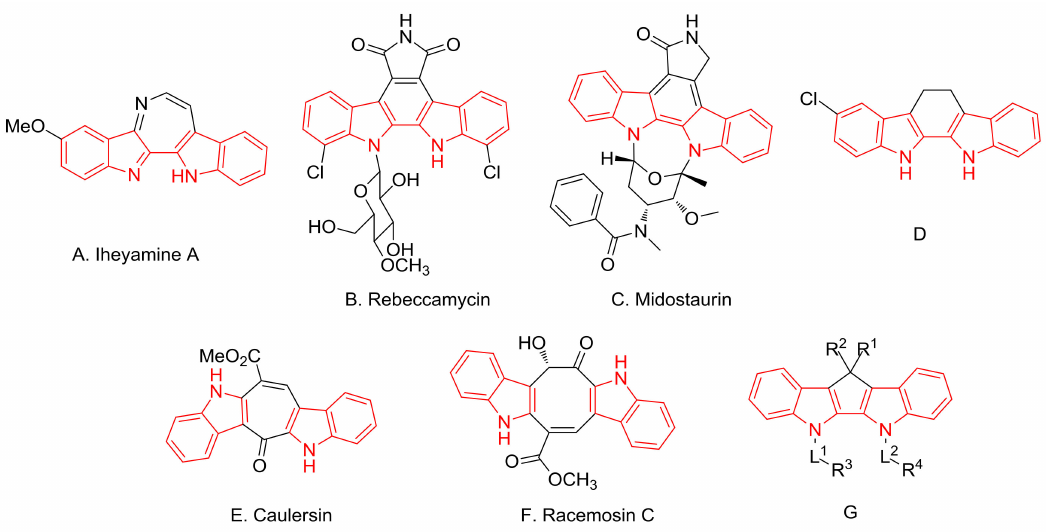
Figure 1. Some bioactive bisindolyl alkaloids and synthetic